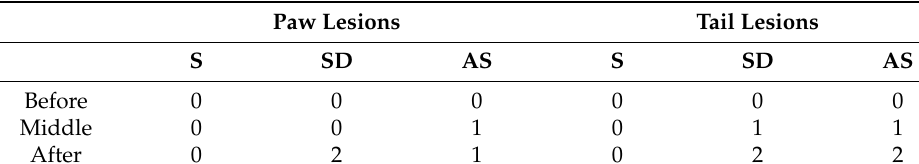
Table 1. Skin lesions during chronic sleep intervention.